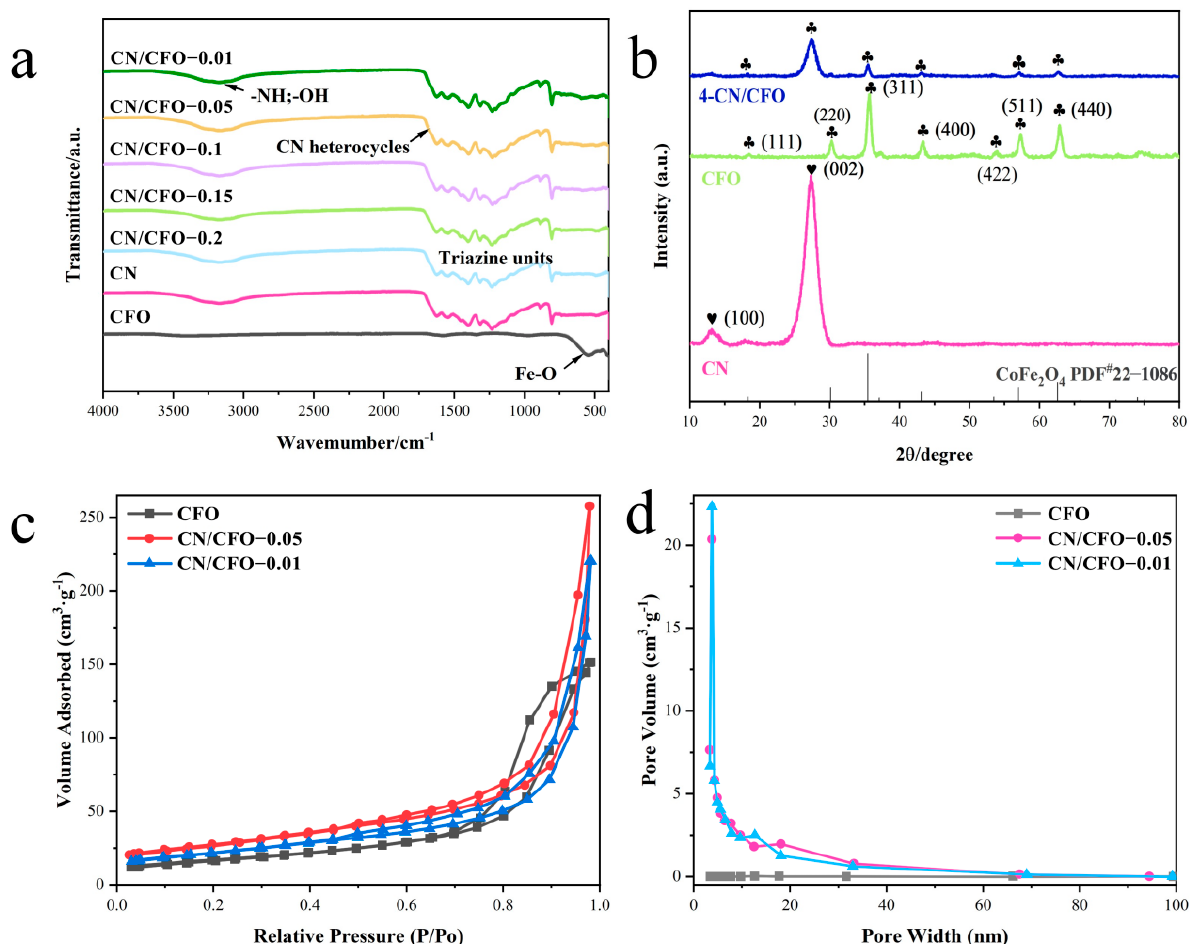
Figure 2. FT-IR patterns of pure CN, CFO and composite samples of different proportions ( a ); X-ray diffraction patterns of pure CN, CFO, and CN/CFO-0.05 ( b ); N 2 adsorption–desorption isotherms of pure CFO, CN/CFO-0.05, and CN/CFO-0.01 ( c ); pore size distribution of pure CFO, CN/CFO-0.05, and CN/CFO-0.01 ( d ).